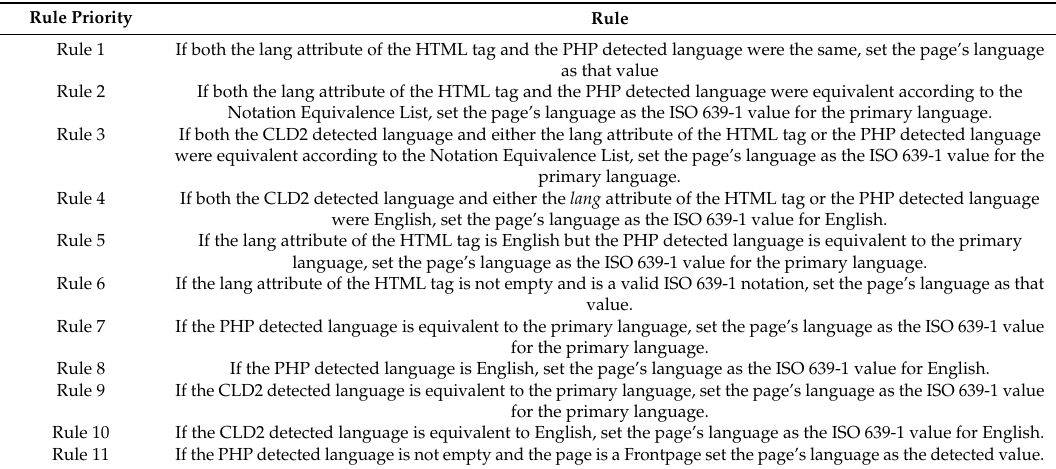
Table 4. Rules used in LIA to infer the language of a